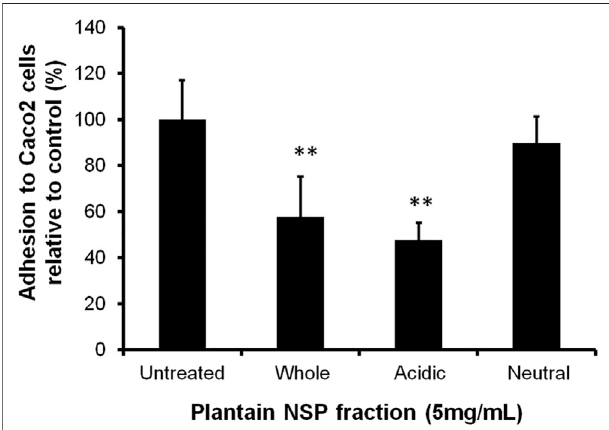
FIGURE 4 | The inhibitory activity of soluble NSP from plantain to block C.dif fi cile -hostintestinalepitheliuminteractionlieswithinanacidic(pectin-rich) polysaccharide component. At 5 mg/ml, the Q-Sepharose puri fi ed acidic polysaccharidefractionofplantainNSPsigni fi cantlyblockedadhesionof C. dif fi cile to con fl uent Caco-2 [Caco2] cell monolayers, whereas the neutral fraction had no signi fi cant effect compared to the untreated control ( N (cid:2) 3 experiments, n (cid:2) 3 replicates, ** p < 0.01, Kruskal-Wallis test).